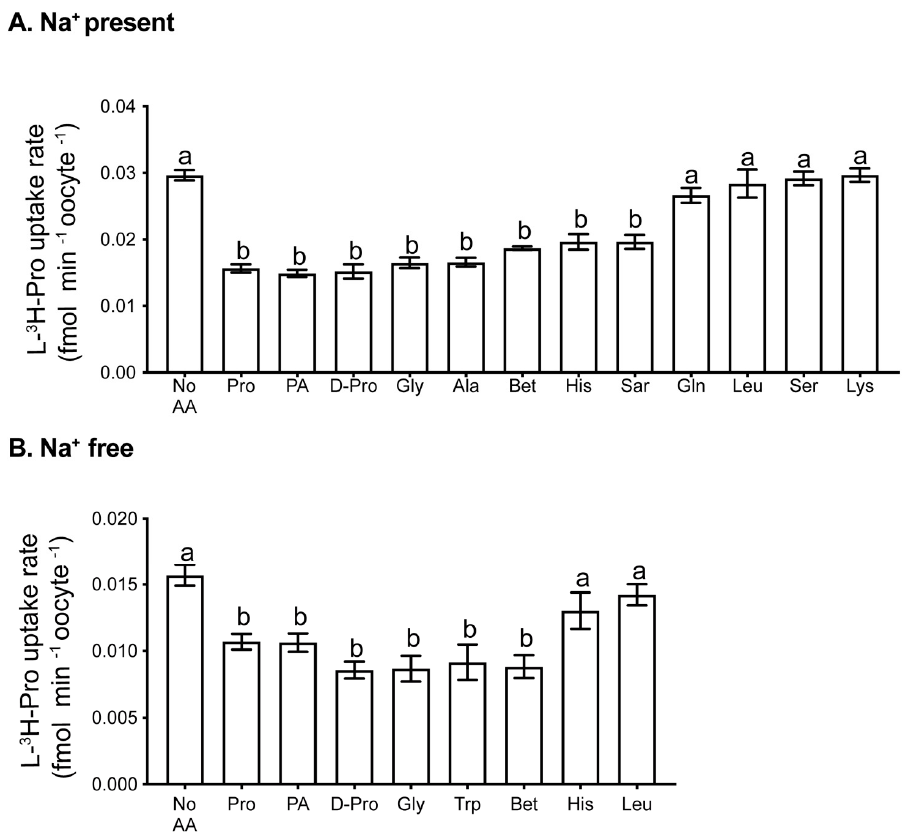
Figure 2. Uptake of L-[ 3 H]-Pro by oocytes in the presence of other amino acids. Rate of uptake of 1 µM L-[ 3 H]Pro in ( A ) mod-HTF containing Na + or ( B ) Na + -free mod-HTF in the presence of unlabelled competing amino acids. The concentration of all competitors was 5 mM, with the exception of Pro (0.4 mM). Each bar represents the mean ± SEM from at least 3 independent experiments, each with treatments performed in triplicates of 4 oocytes. Data were analysed using 1-way ANOVA with Tukey’s post hoc test. Bars with different letters are significantly different ( p < 0.05). Sar: sarcosine.